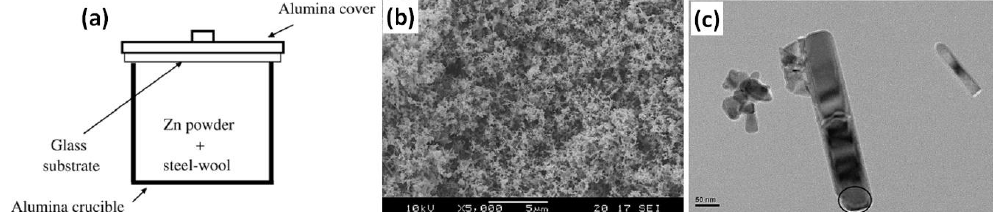
Figure 75. ( a ) The schematic of the sample environment. ( b ) Typical surface-section SEM